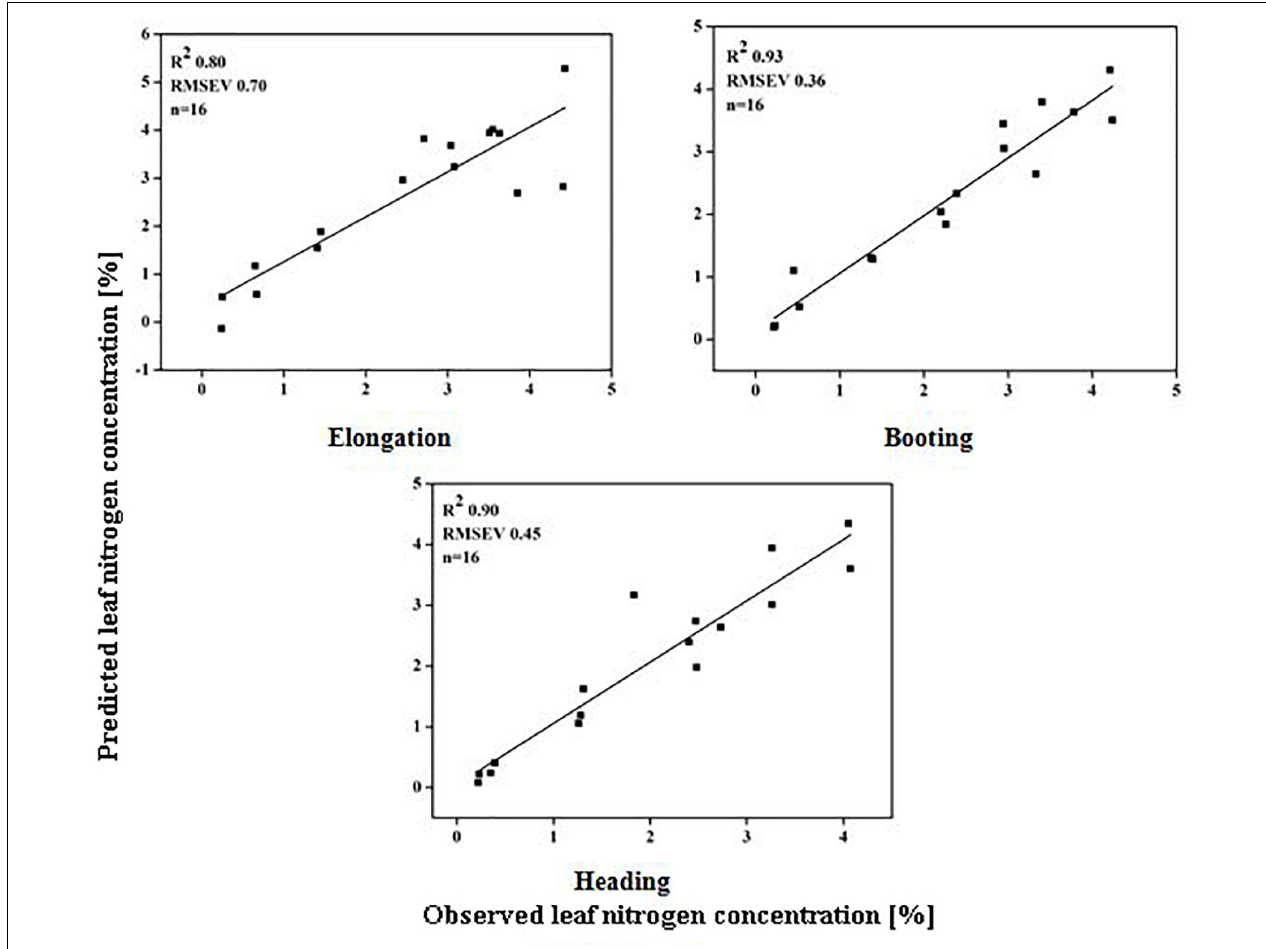
FIGURE 6 | Relationship between predicted and observed leaf nitrogen concentration (%) over phenological stages of